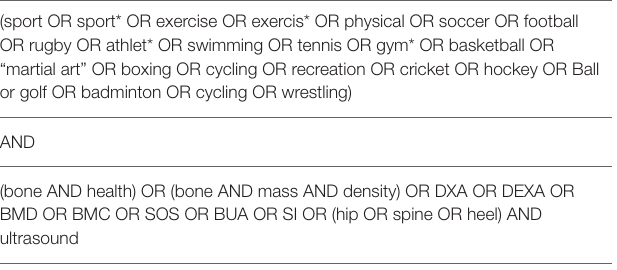
TABLE 1 | Summary of search strings